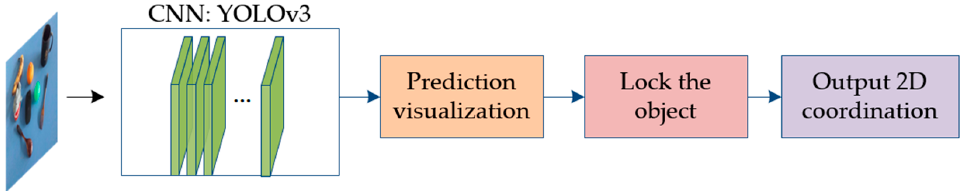
Figure 4. Detection flowchart of 2D coordinates of pointed object.